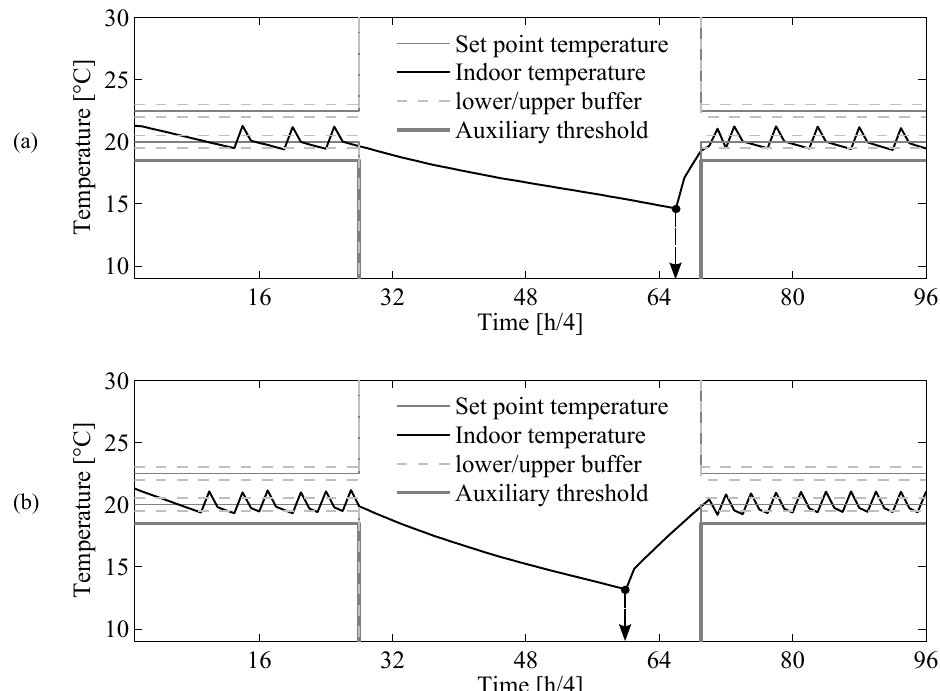
Figure 2. Indoor temperature of two buildings with di ff erent thermal insulation. ( a ) Building with a high thermal insulation level; ( b ) building with a low thermal insulation